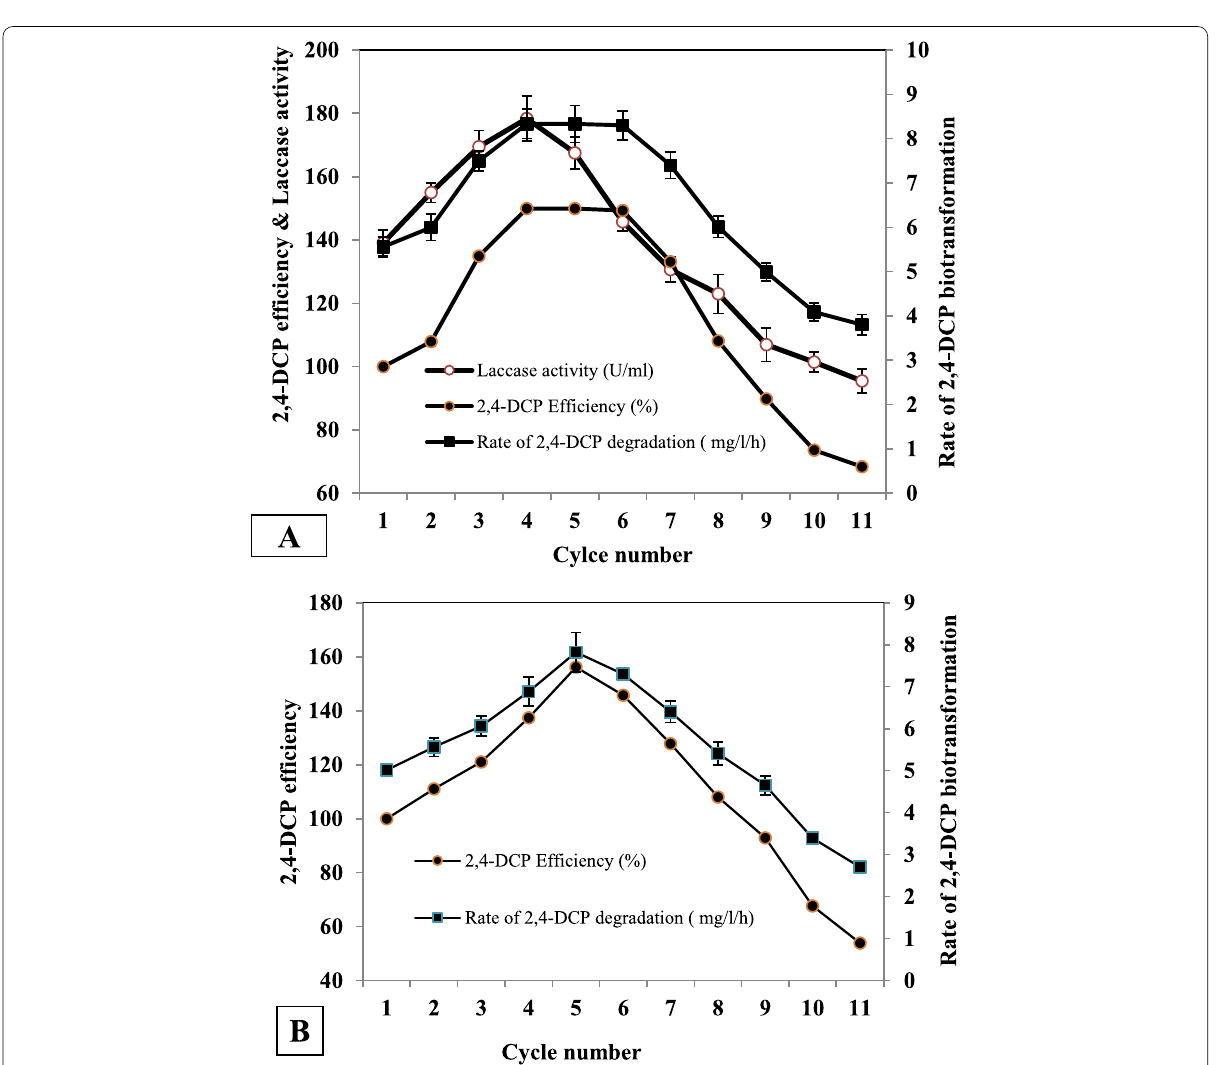
Fig. 4 Biotransformation of 2,4‑DCP by the reused adsorbed B. subtilis AAK cultures ( A ) and immobilized laccase enzyme ( B ). Data are represented as mean SD across technical replicates ( n ± =